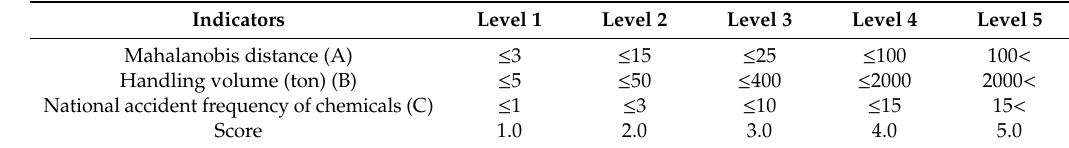
Table 4. Classification criteria and quantification results of each indicator.